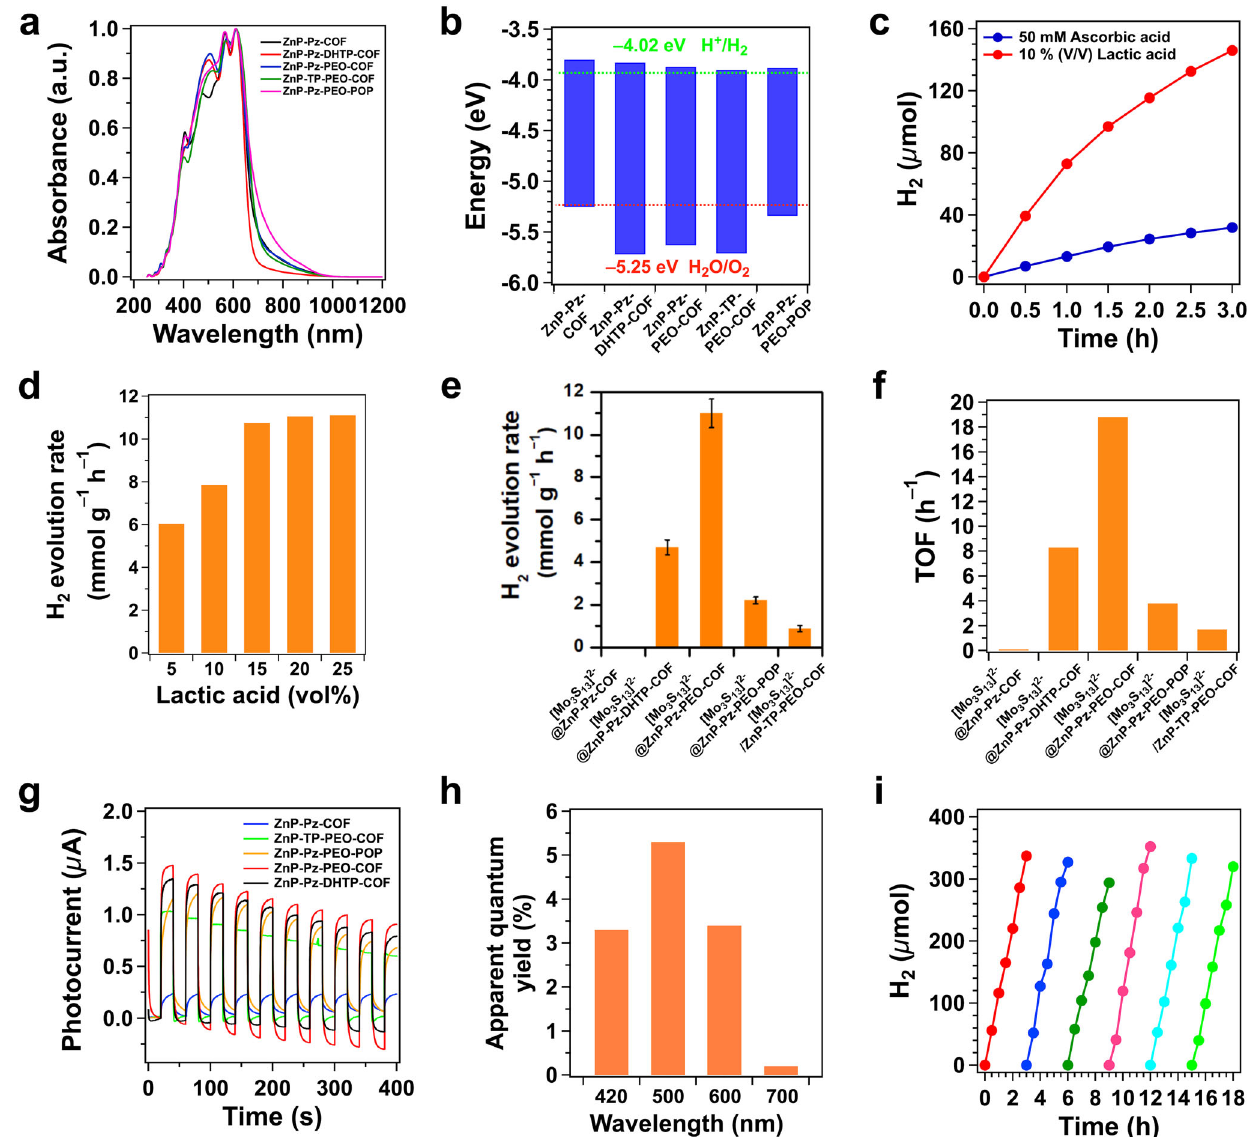
Fig. 5 | Optoelectronic property and photocatalytic activity. a Solid-state elec- tronic diffuse re fl ection absorptionspectra of ZnP-Pz-COF(black), ZnP-Pz-DHTP-COF (red),ZnP-Pz-PEO-COF(blue),ZnP-TP-PEO-COF(green)andZnP-Pz-PEO-POP(purple). b Band gap structures of ZnP-Pz-COF, ZnP-Pz-DHTP-COF, ZnP-Pz-PEO-COF, ZnP-TP- PEO-COF and ZnP-Pz-PEO-POP as well as band energy for proton reduction. c , Time- dependent hydrogen production pro fi les monitored over 3h with [Mo 3 S 13 ] 2 – @ZnP- Pz-PEO-COFinthepresenceof50mMascorbicacid(redcurve)and10vol%lacticacid (blue curve). d Hydrogen evolution rates of [Mo 3 S 13 ] 2 – @ZnP-Pz-PEO-COF with dif- ferent lactic acid concentrations. e Hydrogen evolution rates of [Mo 3 S 13 ] 2 – @ZnP-Pz-